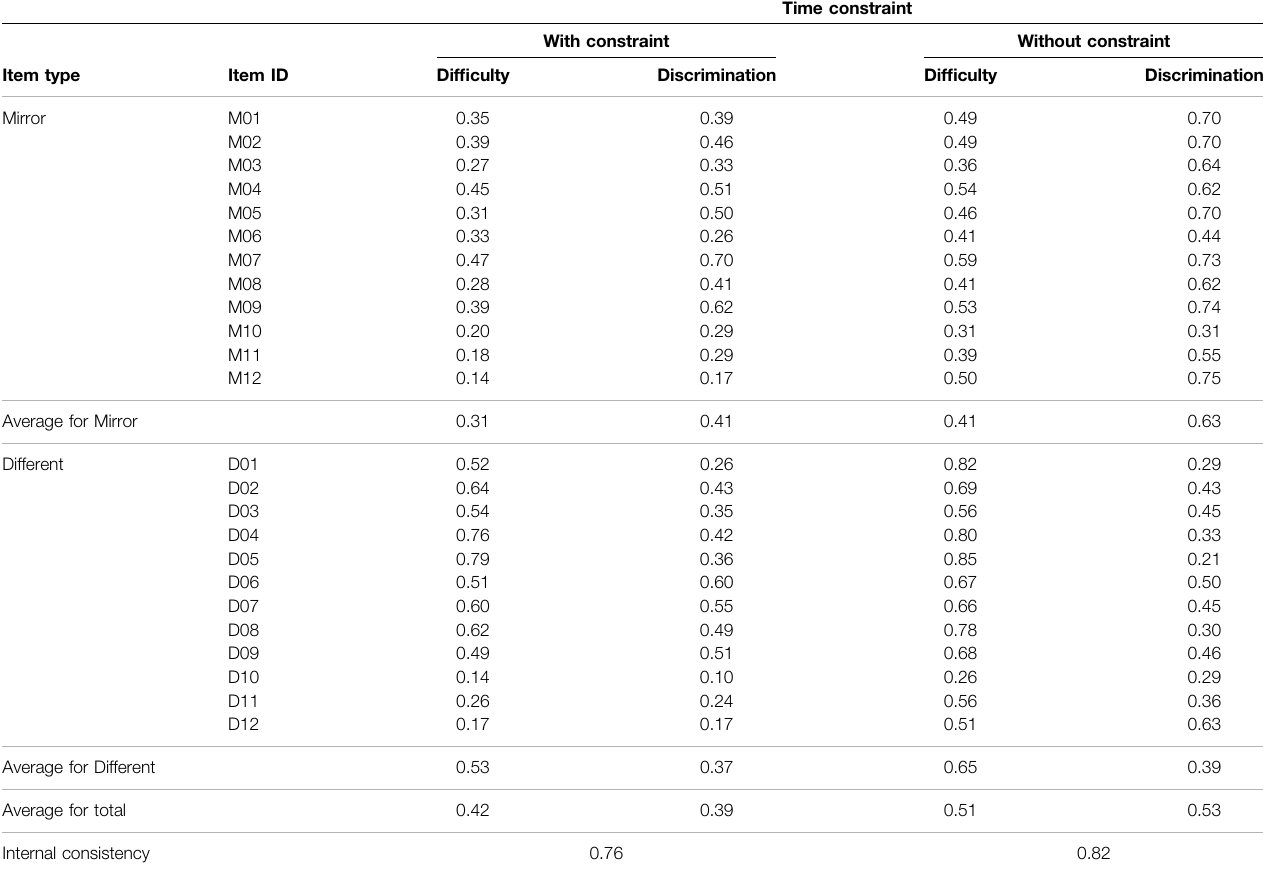
TABLE 3 | Summary item analysis of formal